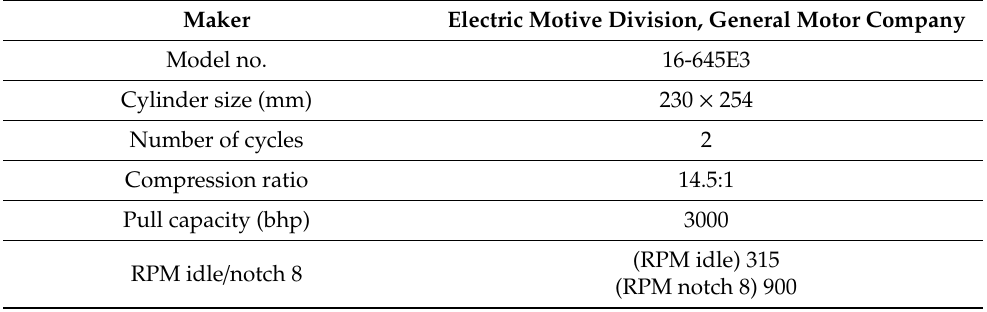
Table 1. Characteristics of the Series 7300 and 7400 diesel locomotive engines used in this study. Maker Electric Motive Division, General Motor Company Model no.